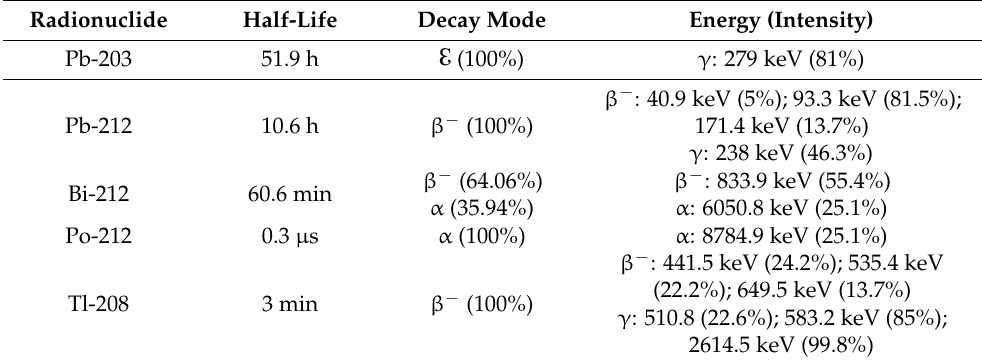
Table 1. Nuclear data of 203 Pb, 212 Pb and progeny.